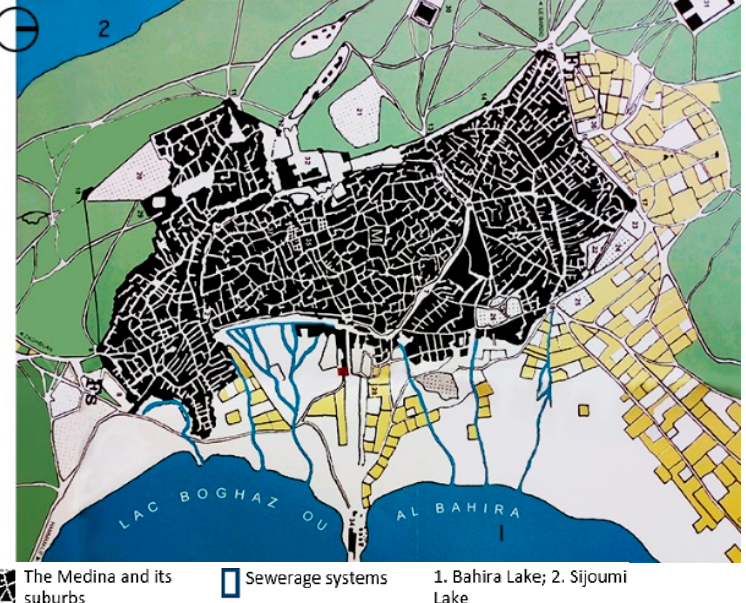
Figure 4. The Medina of Tunis and the beginning of the appearance of surrounding urban forms, in 1860 (adapted data source: Ammar, L. Les enjeux du patrimoine ancien et récent à Tunis aux XIXe et XXe siècles. Al-Sabîl: Revue d’Histoire, d’Archéologie et d’Architecture Maghrébines, 2017, 03).